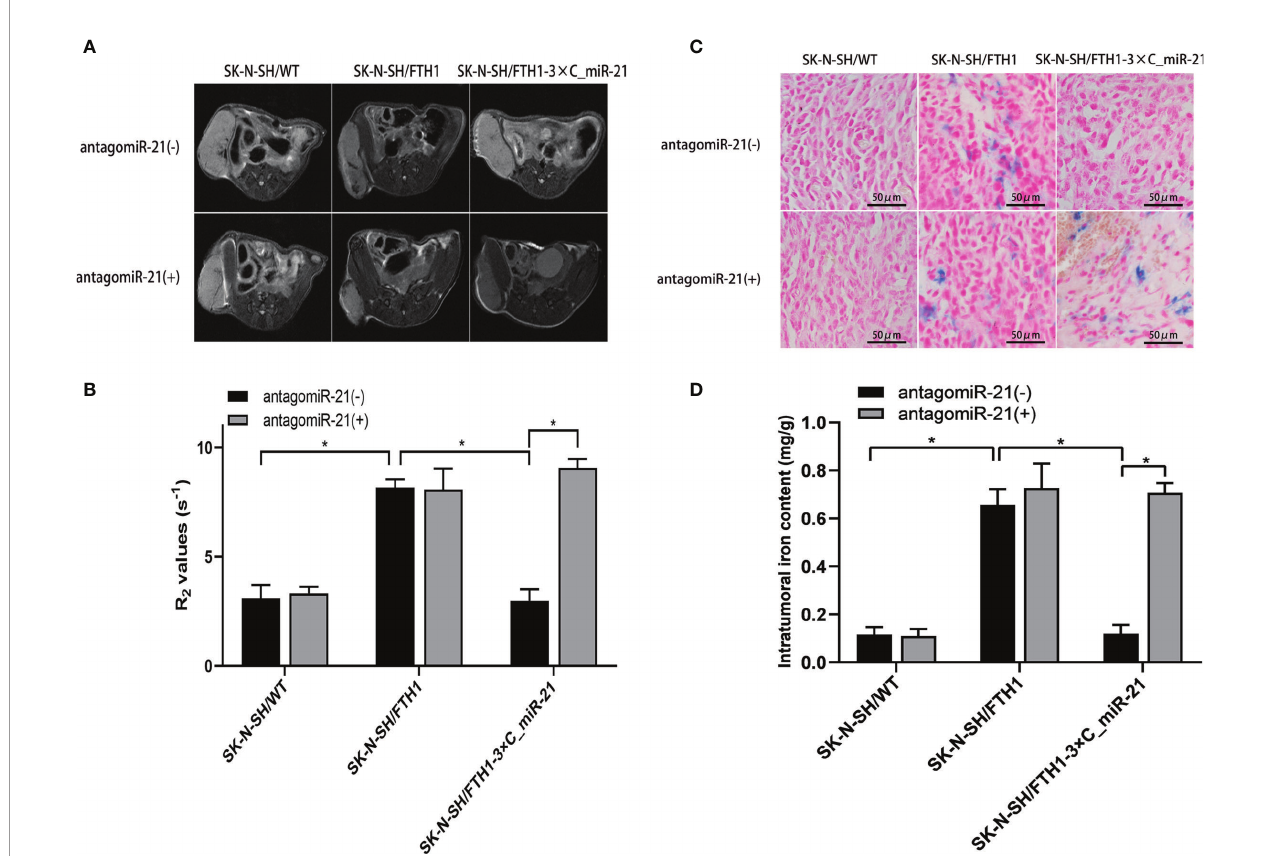
FIGURE 6 | MRI and iron detection in xenografts before and after antagomiR-21 administration. Before antagomiR-21 administration, the MRI signal in the SK-N- SH/FTH1 group was obviously decreased and the R2 value was signi fi cantly increased compared with those in the SK-N-SH/WT group, but these values in the SK- N-SH/FTH1-3×C_miR-21 group did not differ from those in the SK-N-SH/WT group. After treatment with the antagomiR-21, the SK-N-SH/FTH1-3×C_miR-21 group showed a signi fi cantly decreased MRI signal and increased R2 value compared with those prior to treatment. In the other two groups, the MRI signals and R2 values did not differ before and after antagomiR-21 treatment (A, B) . The Prussian blue staining (C) and intratumoral iron content quanti fi cation (D) results match the MRI results. Intratumoral iron accumulation was signi fi cantly increased after antagomiR-21 treatment in only the SK-N-SH/FTH1-3×C_miR-21 group. Three independent experiments were performed. * indicates P <